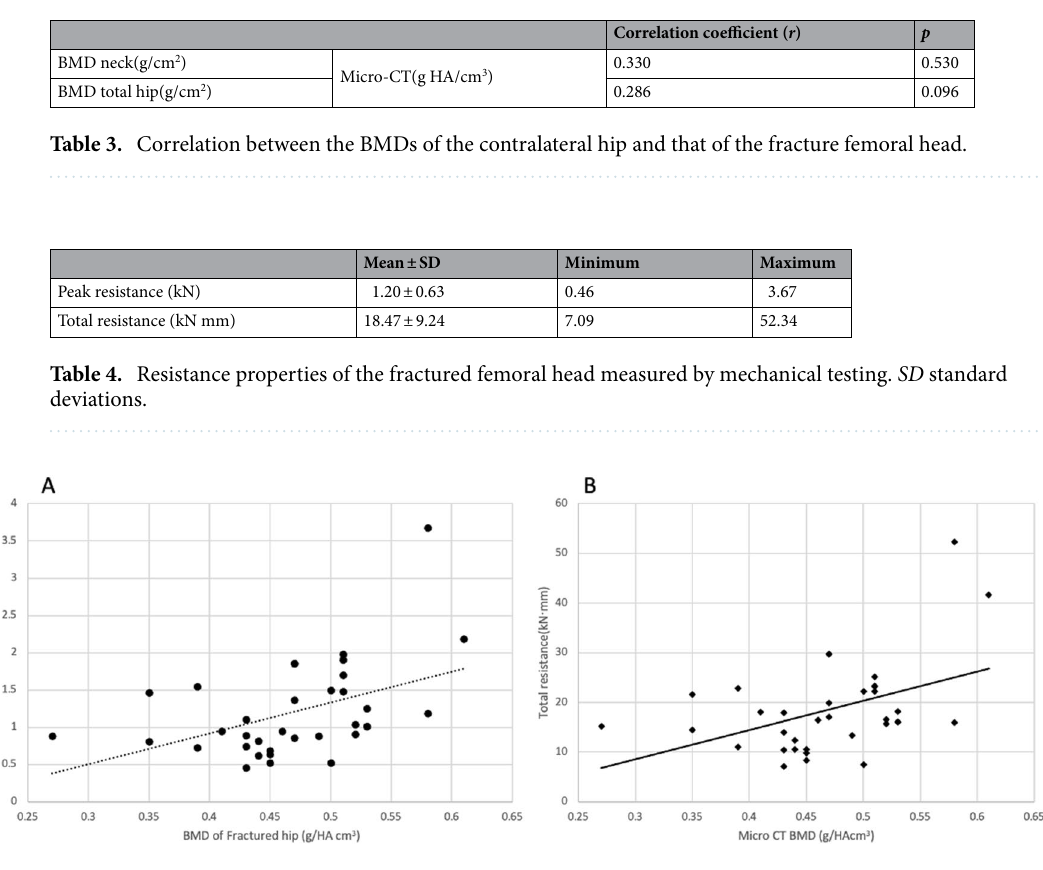
Figure 4. Scatter plot of the BMD of the fractured femoral hip and the resistance properties. ( A ) Correlation between the BMD of fractured femoral head and the peak resistance. ( B ) Correlation between the BMD of fractured femoral head and the total